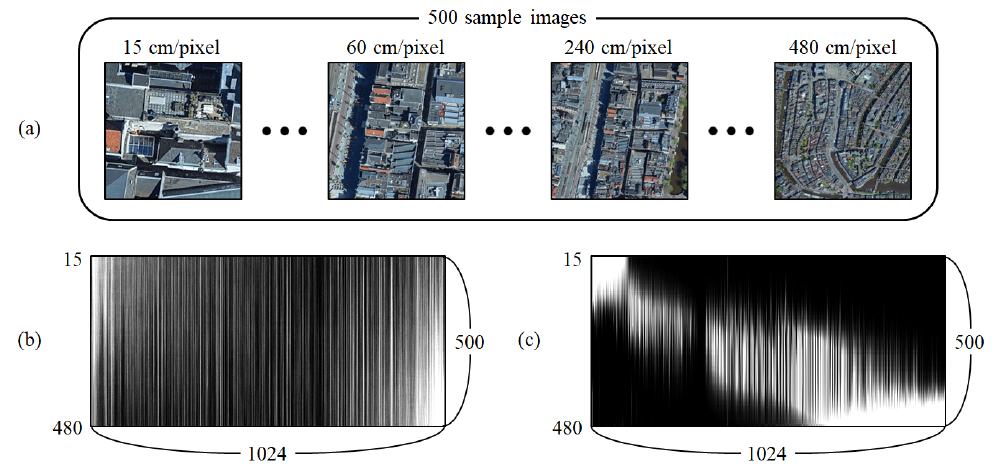
Figure 6. Input images from a Google Earth aerial image of Amsterdam and their stacked feature maps of the last convolution layer of the feature extraction CNN. Each row represents a 1024-D feature map of an image having a specific GSD: ( a ) 500 sample images with a resize ratio of 0.696%; ( b ) ImageNet pre-trained network; ( c ) GSD-trained